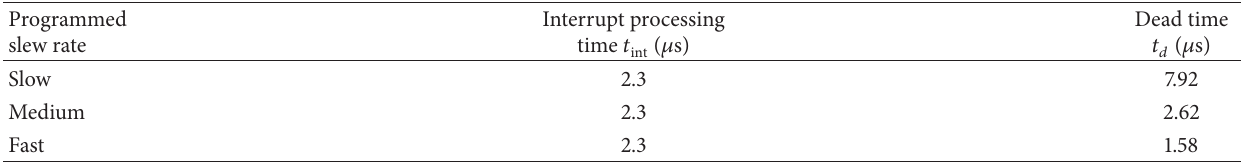
Table 7: Slew rate test auxiliary